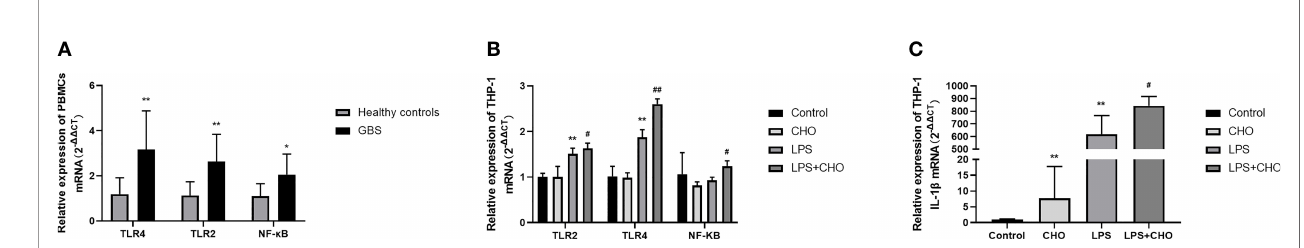
FIGURE 4 | Free cholesterol promoted monocyte activation. (A) The mRNA levels of TLR2, TLR4 and NF- k B in the PBMCs of GBS patients were higher than those of healthy controls. *p<0.05, **p<0.01. (B) Compared with LPS stimulation alone, TLR2, TLR4 and NF- k B mRNA levels of THP-1 cells increased with free cholesterol and LPS costimulation. **: p < 0.01, compared to the control group; # : p<0.05, compared to the LPS group; ## : P<0.01, compared to the LPS group. (C) Free cholesterol increased the mRNA expression of IL-1 b in the presence or absence of LPS. **: p < 0.01, compared to the control group; #: p<0.05, compared to the